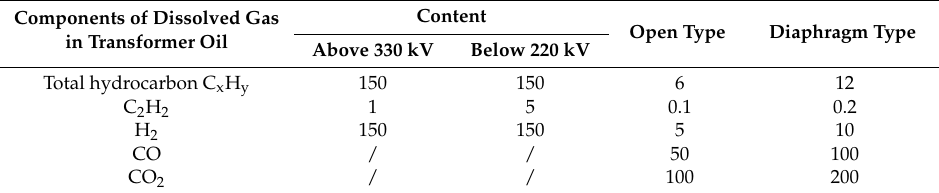
Table 3. The warning value of the content of dissolved gas in transformer oil ( µ